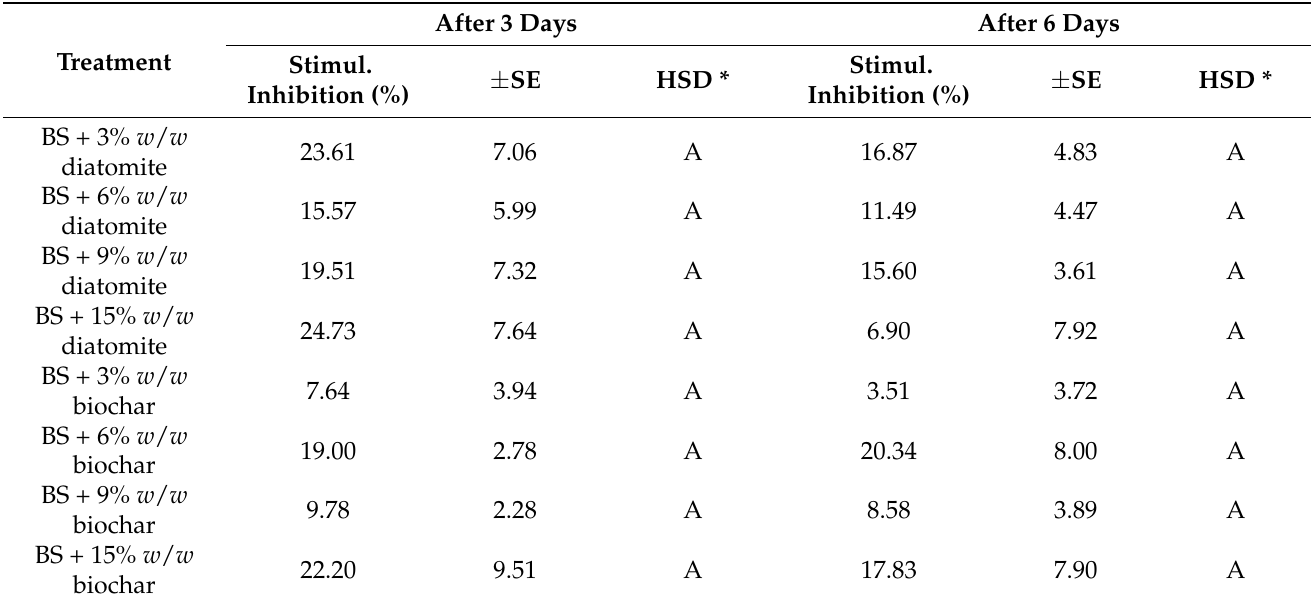
Table 5. Comparison of all average of stimulation/inhibition of root growth of Sinapis alba L. after 3 and 6 days of exposure to burnt soil supplemented with diatomite or biochar in increasing proportions (compared to burn soil).